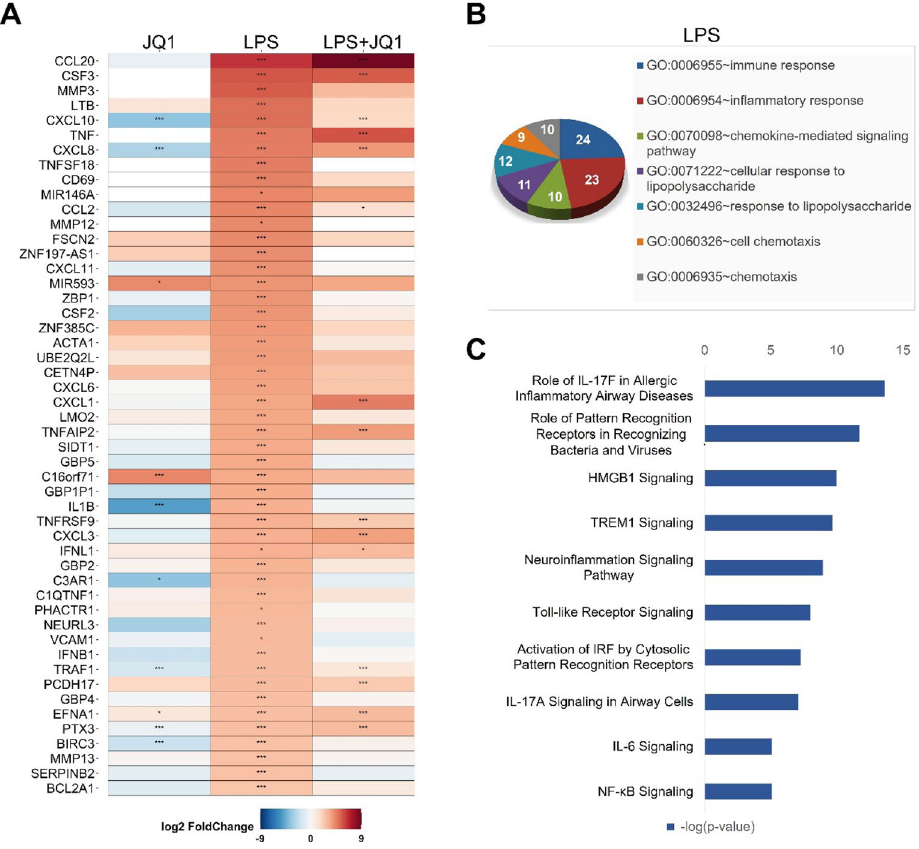
Figure 2. Differentially expressed genes in LPS- and LPS + JQ1-treated HMC3 cells. ( A ) Heat map showing the top 50 upregulated genes in HMC3 cells treated with LPS and LPS + JQ1 for 4 h determined by RNA-seq ( p ≤ 0.05 and fold change ≥ 1.5 log2). Each experiment was performed in experimental triplicates (n = 3) for each condition, and the results were individually combined. The color scale shown in the heat map represents the log 2 fold change values. Red cells indicate upregulated gene, while blue cells indicate downregulated genes. The p-value with an asterisk attached in the cell represents * p < 0.05, ** p < 0.01, and *** p < 0.001. ( B ) GO term analysis of the biological processes associated with up- and downregulated genes after LPS (100 ng/ml) and JQ1 (500 nM) treatment for 4 h. GO analysis of the number of genes shown in the van diagram. ( C ) Biological pathway analysis of DEGs in cells treated with LPS and LPS + JQ1 using IPA (QIAGEN Inc., https:// www. qiage nbioi nform atics. com/ produ cts/ ingen uityp athway- analy sis) showed up- and downregulated